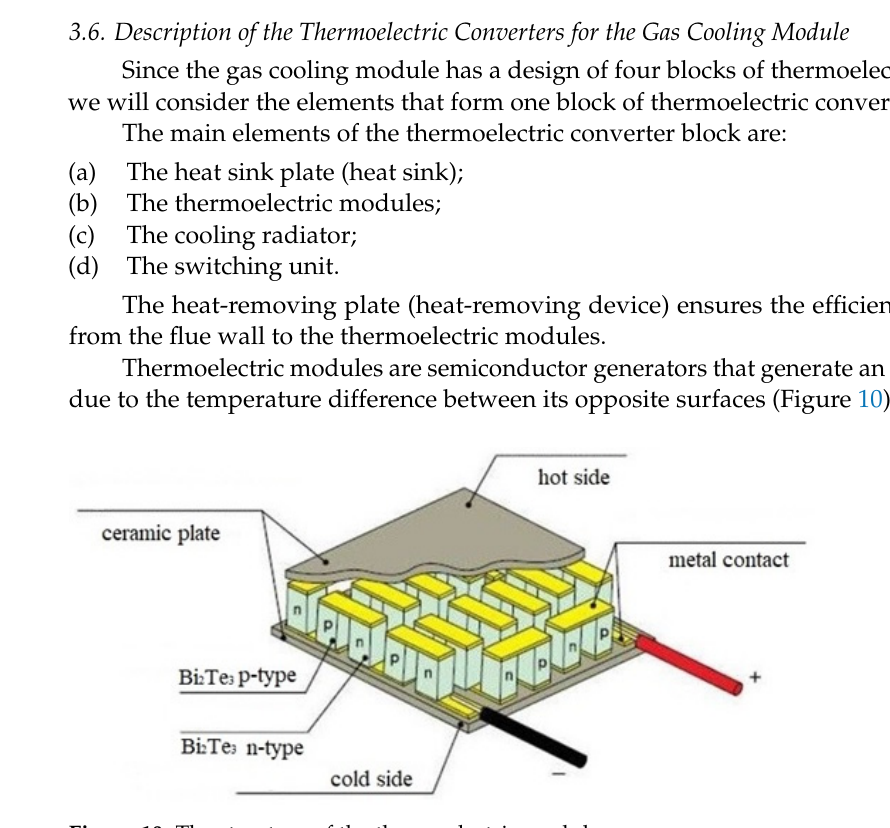
Figure 10. The structure of the thermoelectric module.